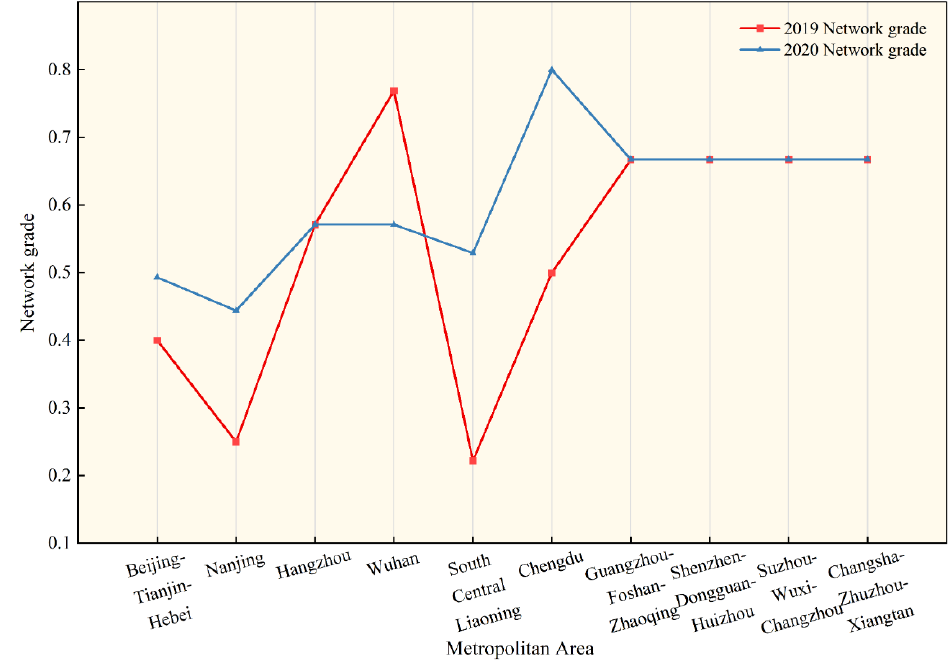
Figure 4. Network grade of PM 2.5 spatial correlation networks in ten metropolitan areas in 2019.